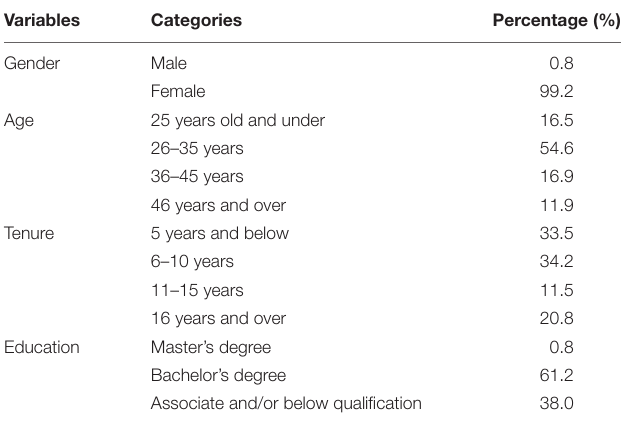
TABLE 1 | Demographic characteristics of the participants (sample size, N =